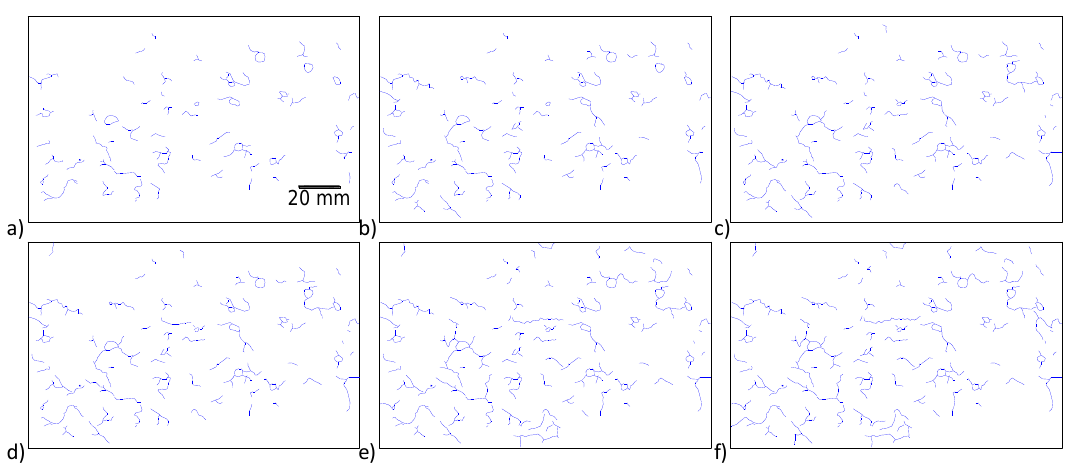
Figure 6. Alkali-silica reactivity (ASR) crack propagation on a 100 × 200 mm cylinder of the larger batch series NaOH-8 mixture ( a ) 114 days, ( b ) 171 days, ( c ) 225 days, ( d ) 342 days, ( e ) 342 days and ( f ) 432 days after casting.